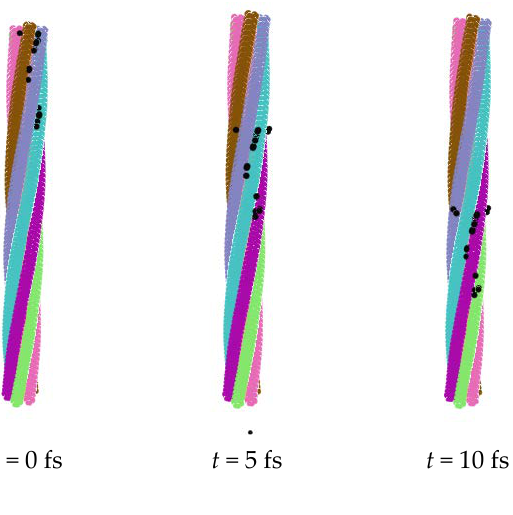
Figure 7. Desorption of negative ions.